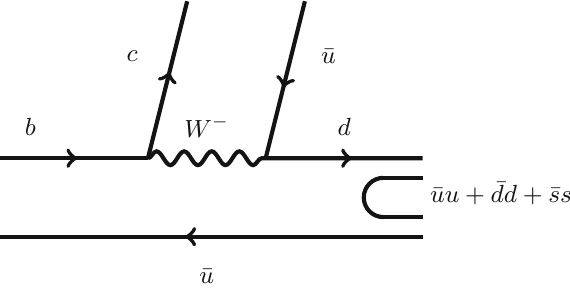
Fig. 3 Diagram for the decay of B − into D ∗ 0 , K ∗ 0 and K − as seen through the quark constituents of the